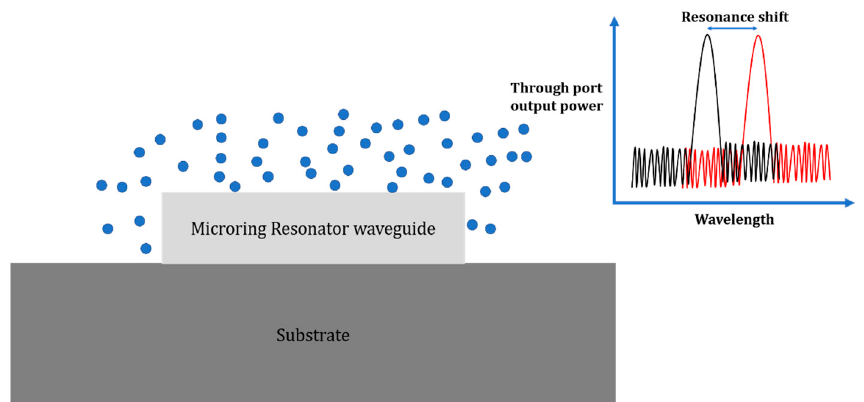
Figure 5. The schematic on how the resonance shift occurs due to the occurrence of glucose analytes on the MRR-based sensor.